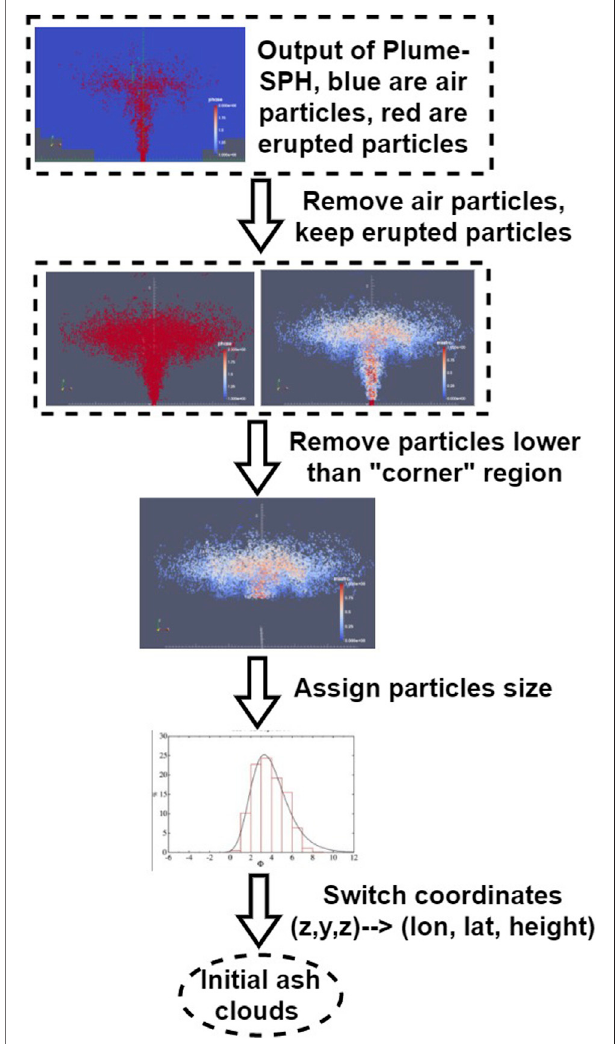
FIGURE 1| Steps to create initial condition for Puff based on raw output of Plume-SPH (Cao et al., 2018). First row: raw output of Plume-SPH. Blue particles are phase 1 (ambient air), and red particles are phase 2 (erupted material). Second row: plume after removing SPH particles of phase 1. Picture at right is colored according to the mass fraction of erupted material. Third row: volcanic plume above the “ corner ” region after cutting off the lower portion. Fourth row: assign sizes to particles converting numerical discretization points into tracers. Fifth row: switch coordinates in local coordinate system into ( longitude , latitude , height